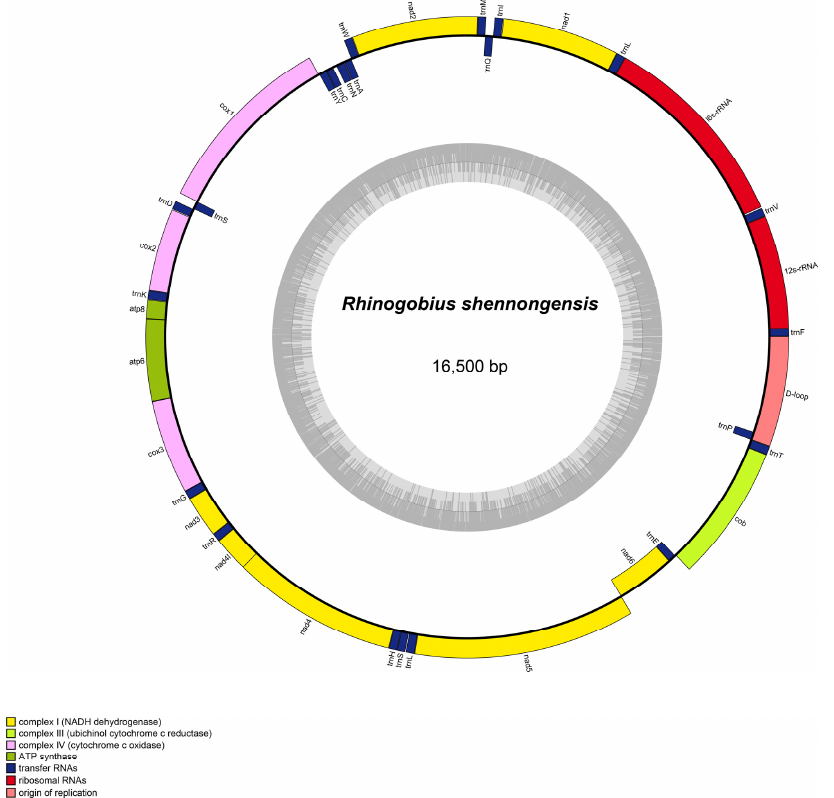
Figure 1. Gene map of mitogenome of Chaenogobius annularis . The genes outside the circle are transcribed clockwise, whereas the genes inside the circle are transcribed counterclockwise.